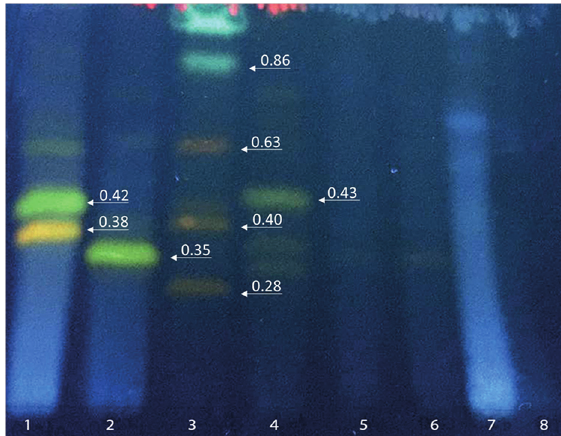
Figure 1 - TLC plate for the identifi cation of fl avonoids in the extracts from in vitro derived materials of four Passifl ora species. 1-4 Leaves of P. alata (1), P. pohlii (2), P. suberosa (3), P. foetida (4). 5-8 Roots of P. alata (5), P. pohlii (6), P. suberosa (7), P. foetida (8). Mobile phase: AcOEt:formic acid:AcOH:H O (100:11:11:26, v/v). Visualization: NP/PEG 2 4000/UV . 365nm